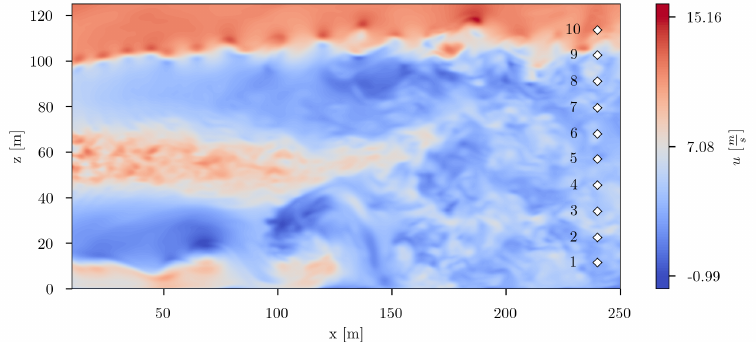
Figure 3. Vertically placed measurement points (white rhombuses) used for error estimation. Snap- shot at i t = 0 in the